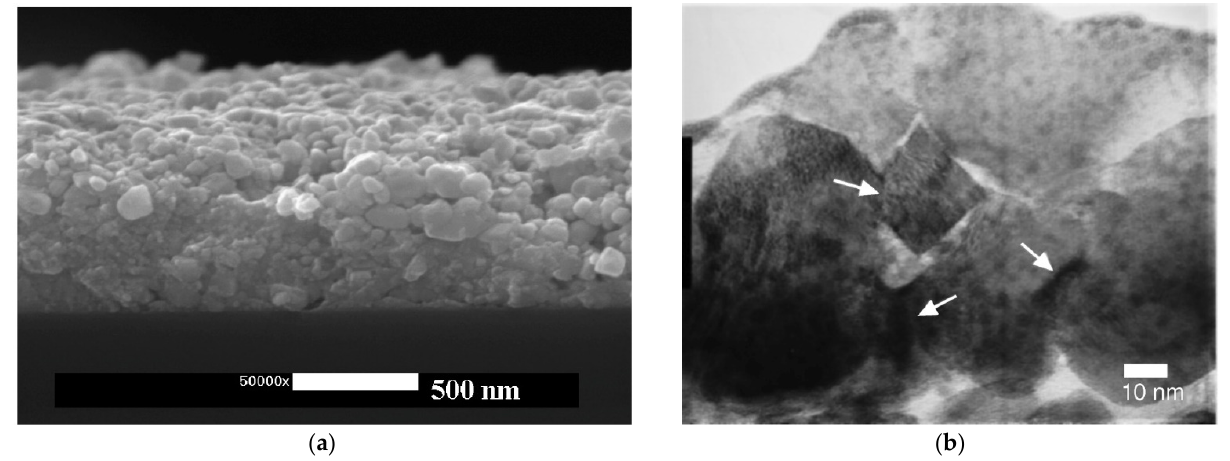
Figure 32. Cross-section of the WO 3 film sprayed by the LPCS process on the silicon substrate: FESEM ( a ) and TEM ( b ) images [298]. Reprinted with permission from [296]. Copyright 2004 Elsevier. Arrows indicate single fine particles interlocking.